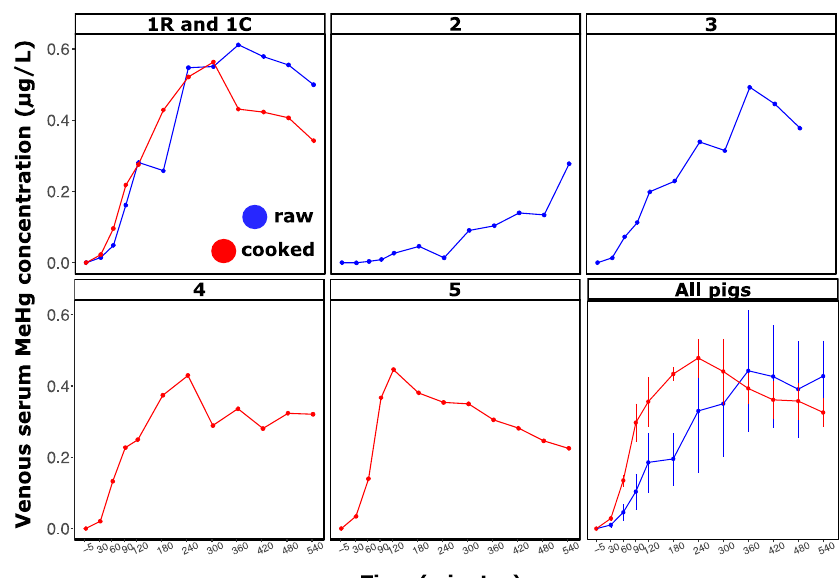
Figure 2. Venous serum MeHg concentration ( µ g/L) of five individuals during the 540 min post- consumption of a single raw (1R, 2, 3) or cooked tuna meal (1C, 4, 5). Values differed from zero (time effect, p < 0.05) and were influenced by treatments (time effect × treatment, p < 0.05). Panel “All pigs” presents the average (± SEM) of venous serum MeHg concentration ( μ g/L) for raw ( n = 3) and cooked ( n = 3) tuna meals. Serum MeHg averages from raw and cooked treatments were similar (Wilcoxon test, p > 0.05). Preconsumption concentration was subtracted from each value. Table 2. Details of the dose of MeHg ingested and MeHg changes in pig serum. Raw Cooked Pig Number 1R * 2 3 1C * 5 Preconsumption values ( µ g/L) 0.20 0.07 AUC (0–540) ( µ g × min/L/ µ g) Cmax (t0 corrected) ( µ g/L) Tmax (min) 360 NA † 360 300 240